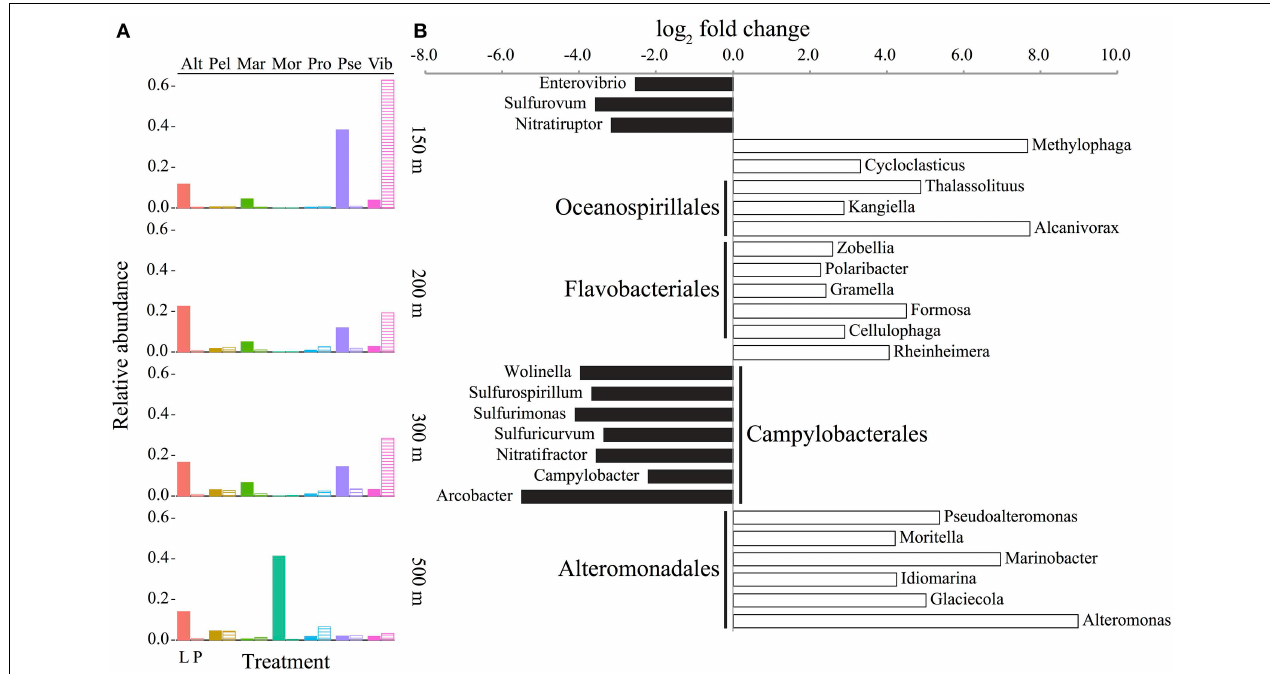
FIGURE 4 | Abundance and enrichment of bacteria in sediment traps assessed by the taxonomic identification of protein-coding genes. (A) Genera with at least 2% mean abundance in traps relative to all sequences (including Archaea and Eukarya) in live (L, filled columns) and poisoned (P, striped columns) sediment traps at the indicated depths. Alt, Alteromonas ; Pel, Candidatus Pelagibacter ; Mar, Marinobacter ; Mor, Moritella ; Pro, Prochlorococcus ; Pse, Pseudoalteromonas ; Vib, Vibrio . (B) Representative